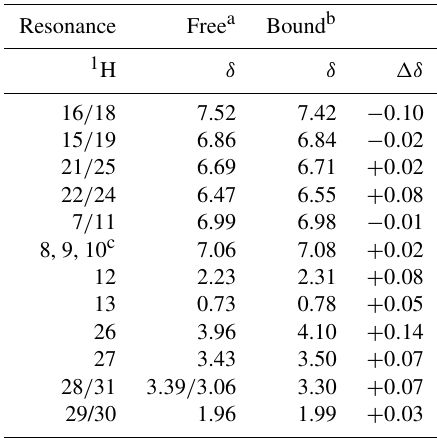
Table 1. 1 H chemical shifts of idoxifene, free in solution and bound to